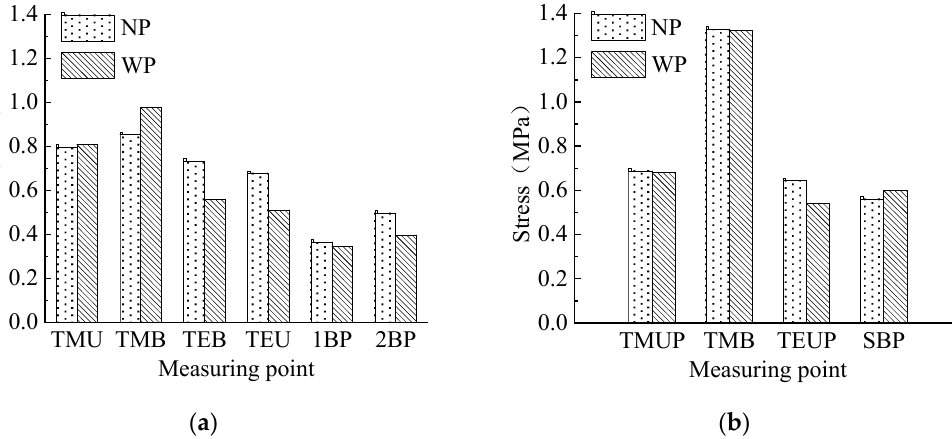
Figure 17. The vertical stress of the rail seats and the bottom of the cast-in-place concrete during the running period. ( a ) Rail seats and ( b ) cast-in-place concrete.